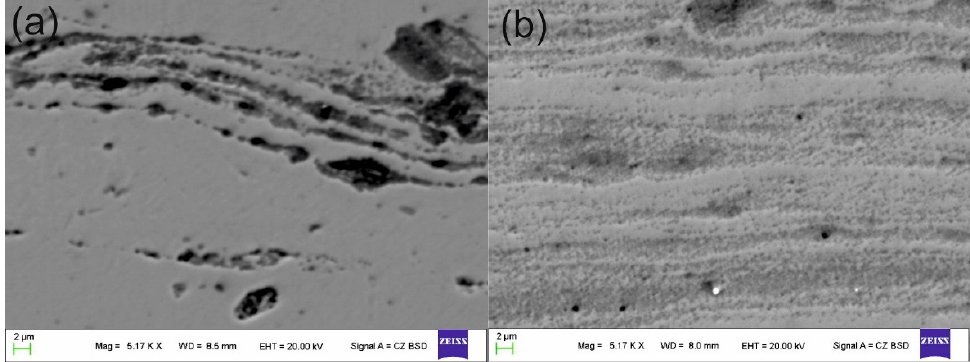
Figure 3. SEM image of HSHPT-processed metallic composite: ( a ) 12 layers, ( b ) 24 layers.